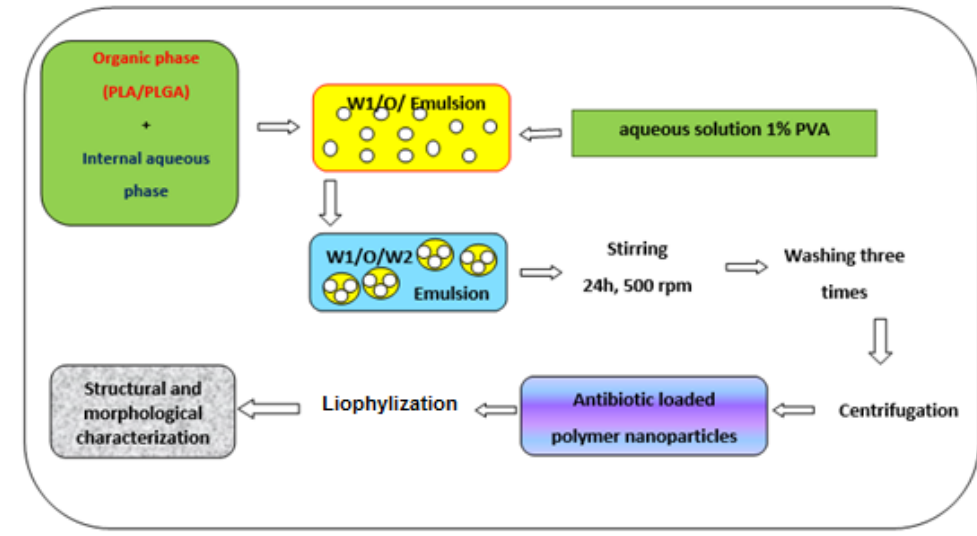
Figure 4. General scheme for erythromycin ‐ loaded PLA/PLGA nanoparticles preparation.